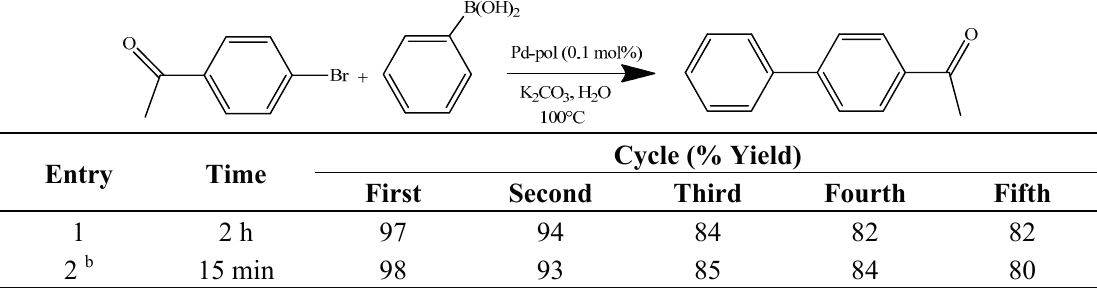
Table 1. Suzuki reaction of 4-bromoacetophenone and phenylboronic acid in water under air over five cycles a